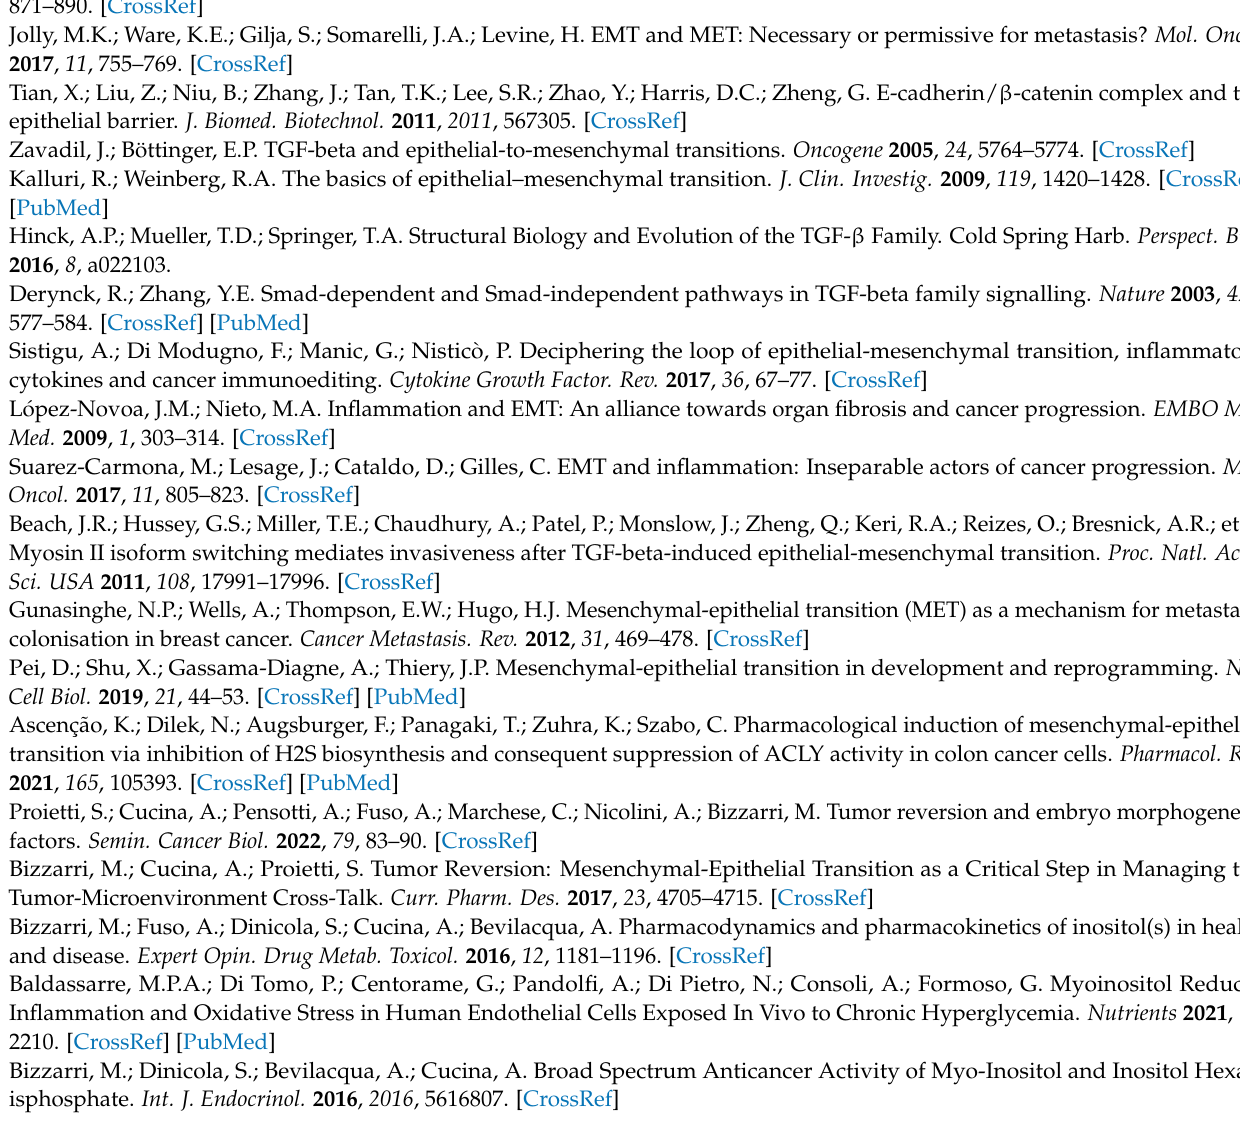
and invasiveness upon TGF- β induction; Table S1: List of Primers used. Figure S2: Whole of western blot